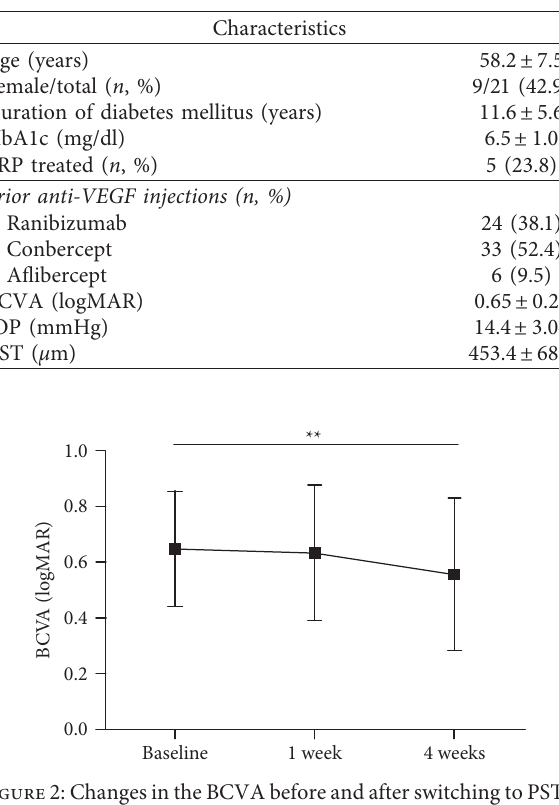
Figure 1: Enhanced depth SD-OCTimage and converted binary image of the eye with refractory DME. The prebinarized SD-OCTimage of the eye with refractory DME. The region within the dotted lines represent the selected TCA. SFCT (white arrow) is defined as the vertical distance from the outer surface of the retinal pigment epithelium to the choroidal-scleral interface (a). The postbinarized SD-OCTimage of the eye with refractory DME (b). Table 1: Patient clinical characteristics ( n � 21).